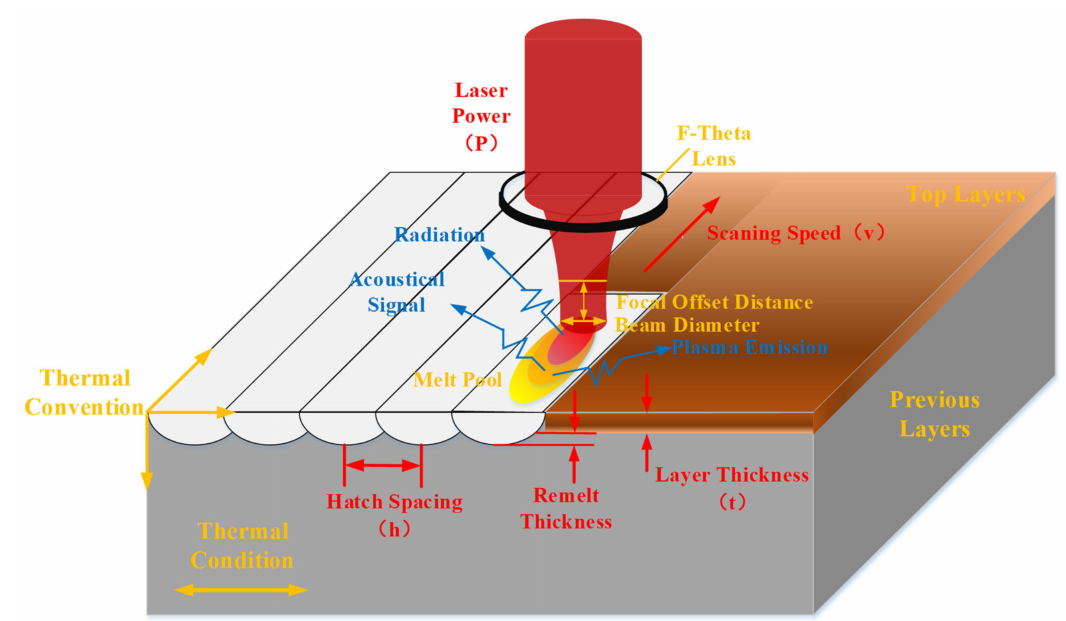
Figure 2. Thermal behavior in selective laser melting.